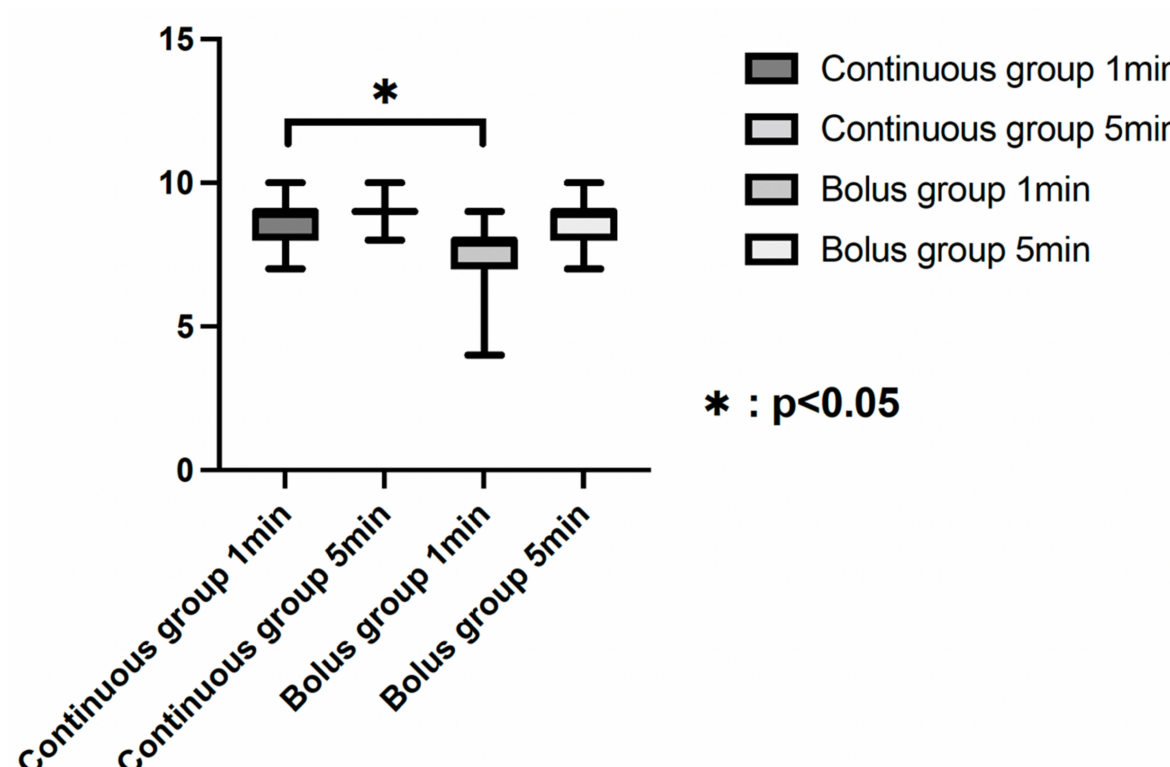
Figure 1. APGAR score (1 min/5 min) in the Continuous group and the Bolus